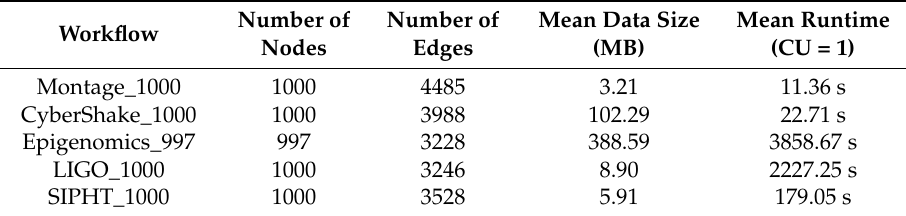
Table 2. Characteristics of the benchmark workflows. CU: Compute Unit.